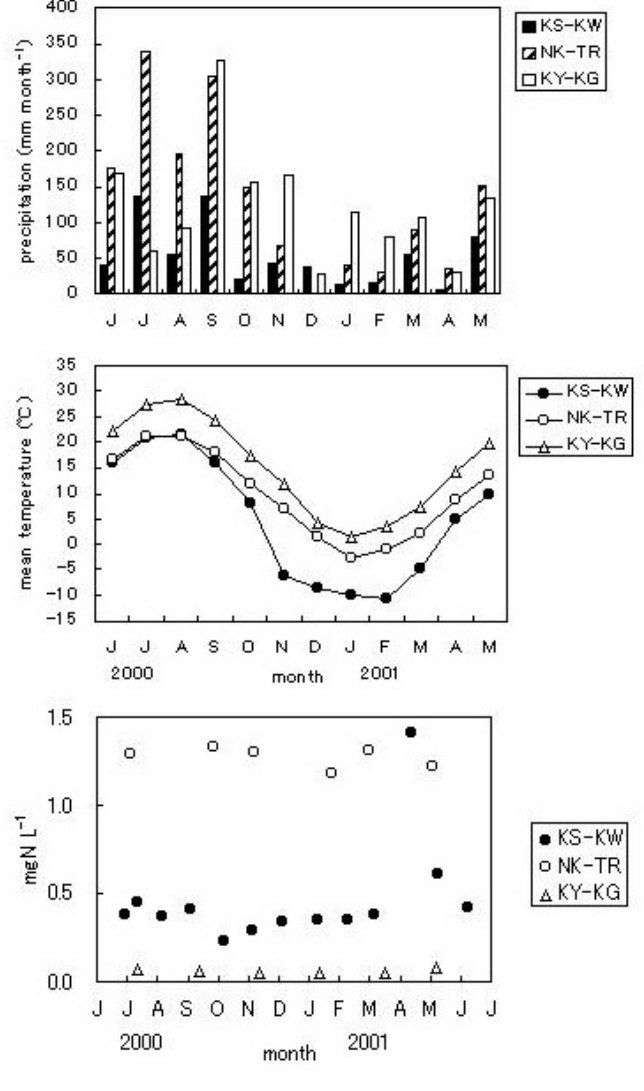
FIGURE 5 . Monthly precipitation (top), monthly mean temperature (middle), and nitrate concentration in stream water (bottom) in KS-KW, NK-TR, and KY-KG from June 2000 to May